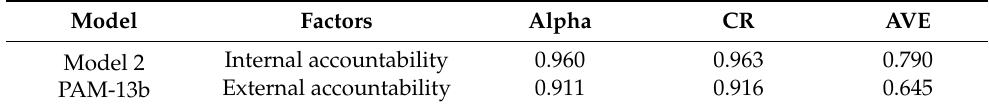
Table 4. Results from reliability, convergent, and discriminant validity